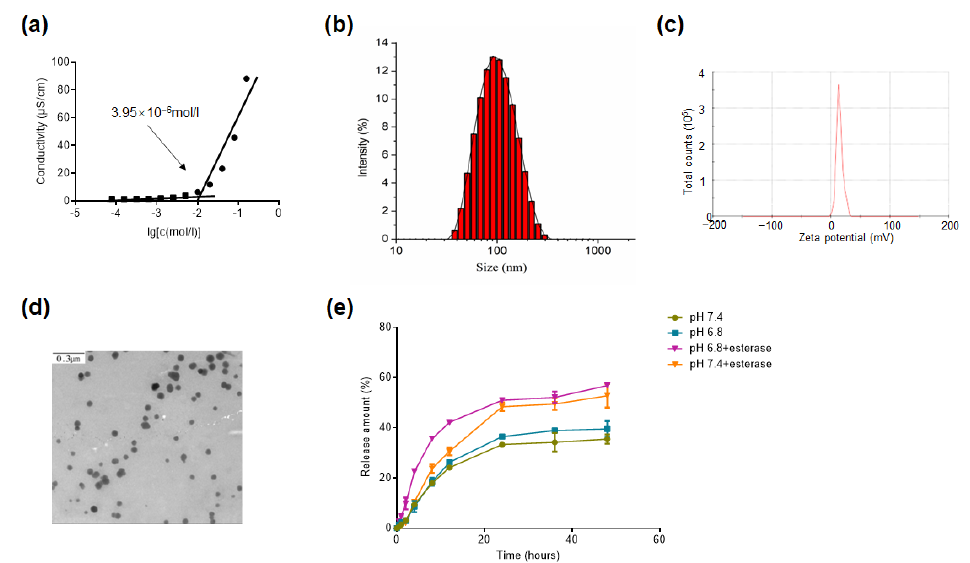
Figure 3. Representation of nanoparticles. ( a ) Determination of critical aggregation concentration of PTX-SM-TAR solution by conductivity method. ( b ) Size distribution of PTX-SM-TAR NPs. ( c ) Zeta potential of PTX-SM-TAR NPs. ( d ) TEM image of PTX-SM-TAR NPs. ( e ) In vitro release curves of PTX-SM-TAR NPs in different conditions (pH 6.8, pH 7.4, pH 6.8 with esterase, and pH 7.4 with esterase).